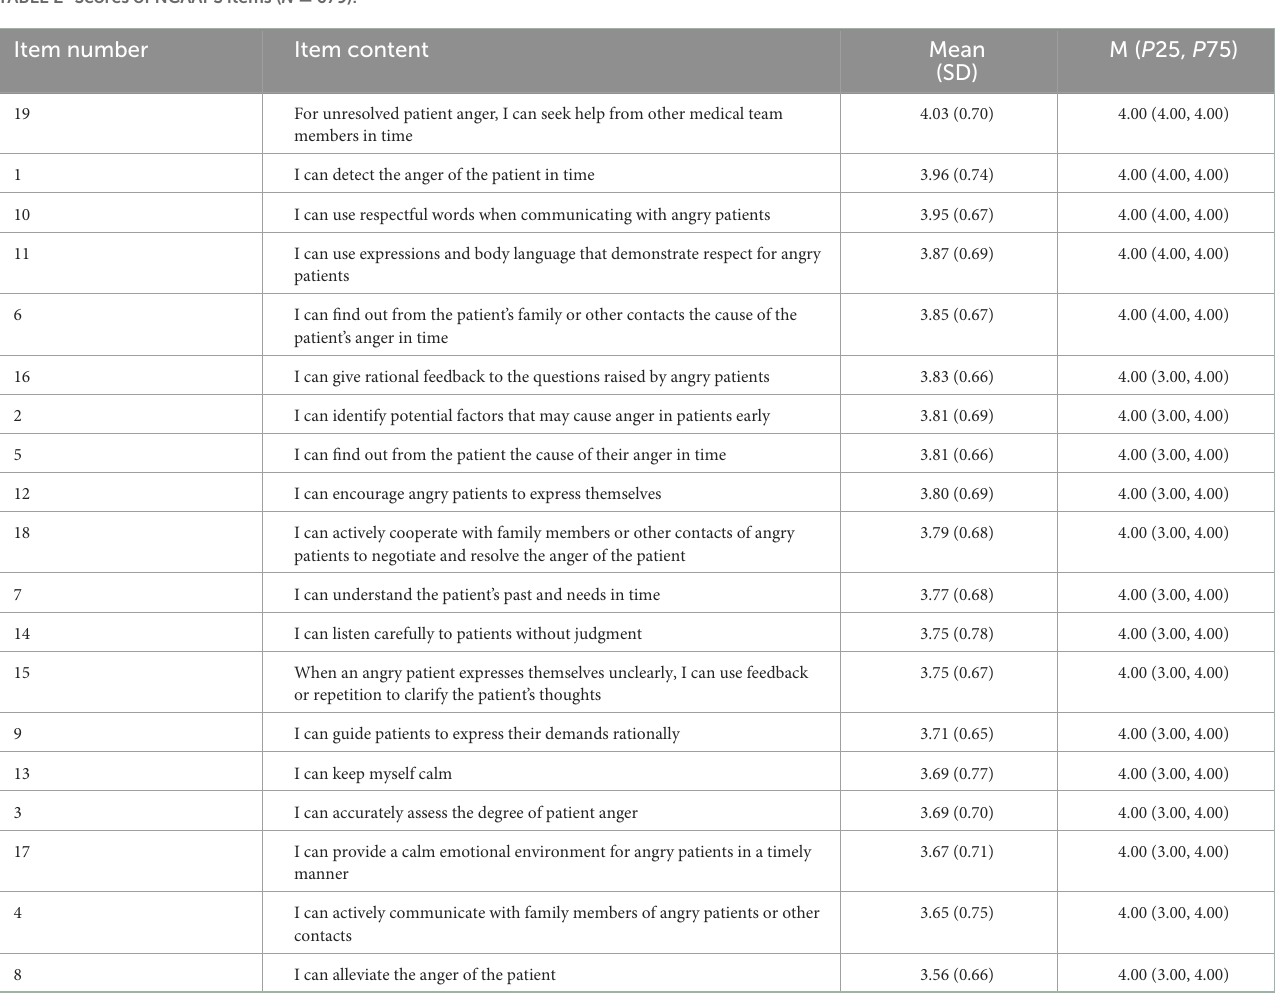
TABLE 2 Scores of NCAAPS items ( N =